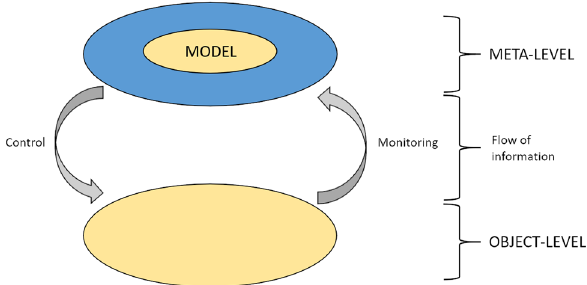
Figure 1. Nelson and Narens’ formulation of a meta-level/object-level theoretical comprising consisting of two structures (meta-level and object-level) and two relationships in terms of the direction of the flow of information between the two levels. The meta-level contains an imperfect model of the